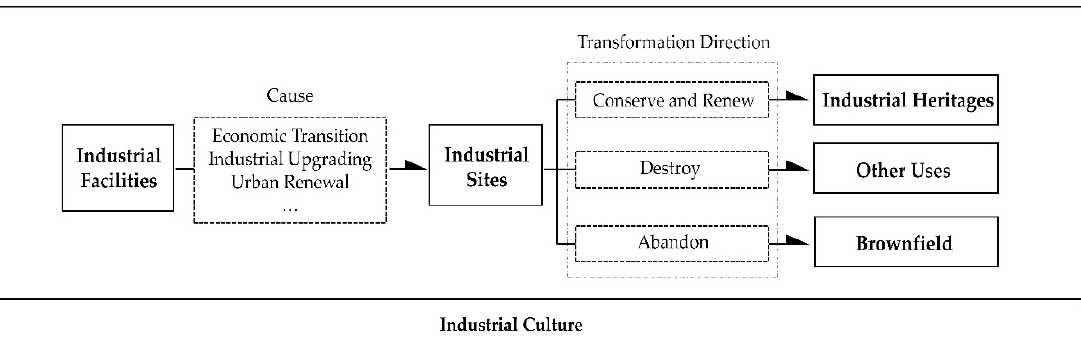
Figure 1. The internal relationship between industrial sites and industrial